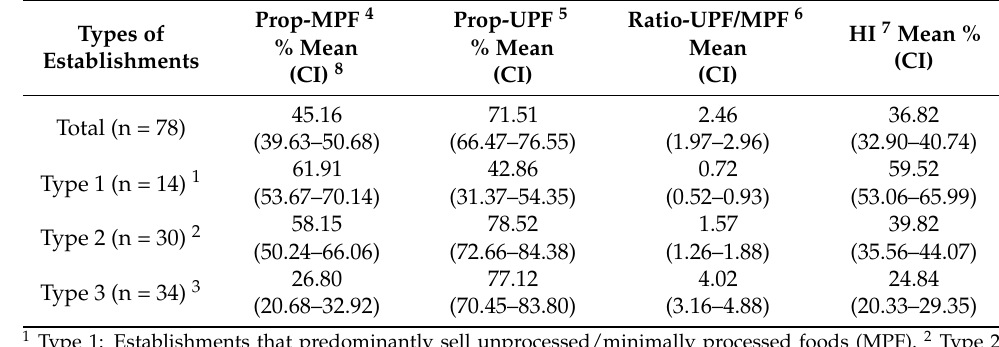
Table 2. Application of indicators of availability of foods for immediate consumption in commercial establishments located in two public universities, according to types of establishments. Rio de Janeiro, Brazil,